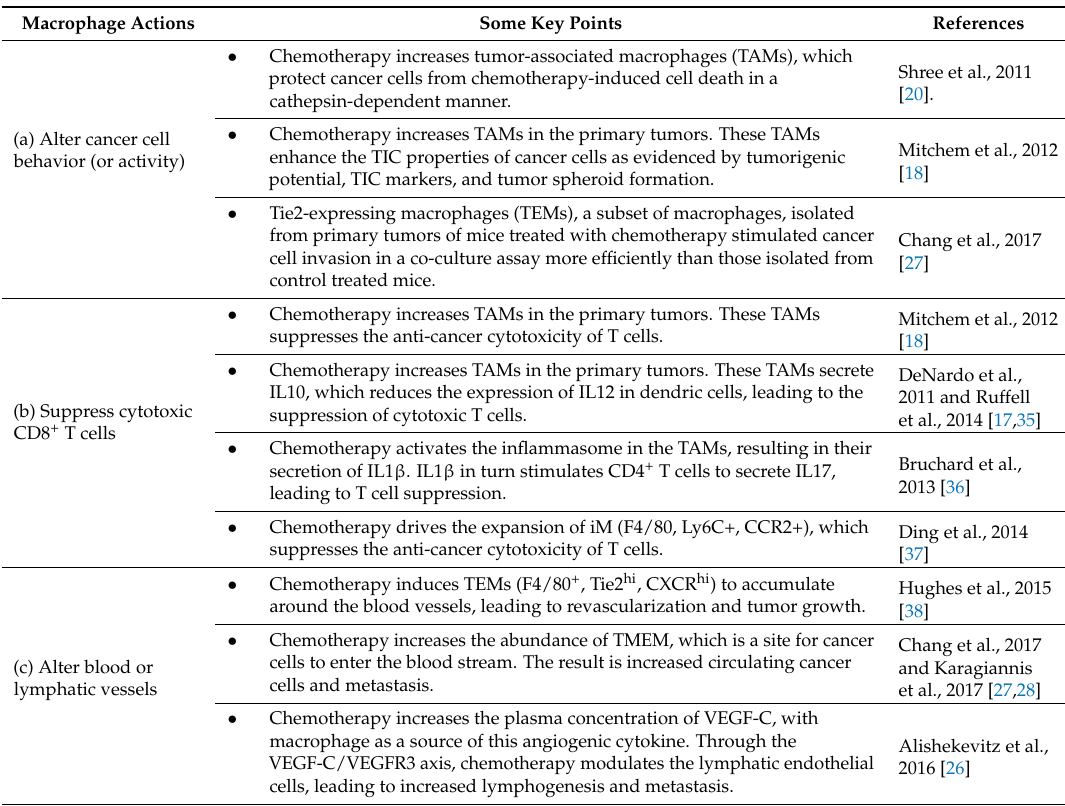
Table 1. Examples of macrophage modulations by chemotherapy to elicit pro-cancer